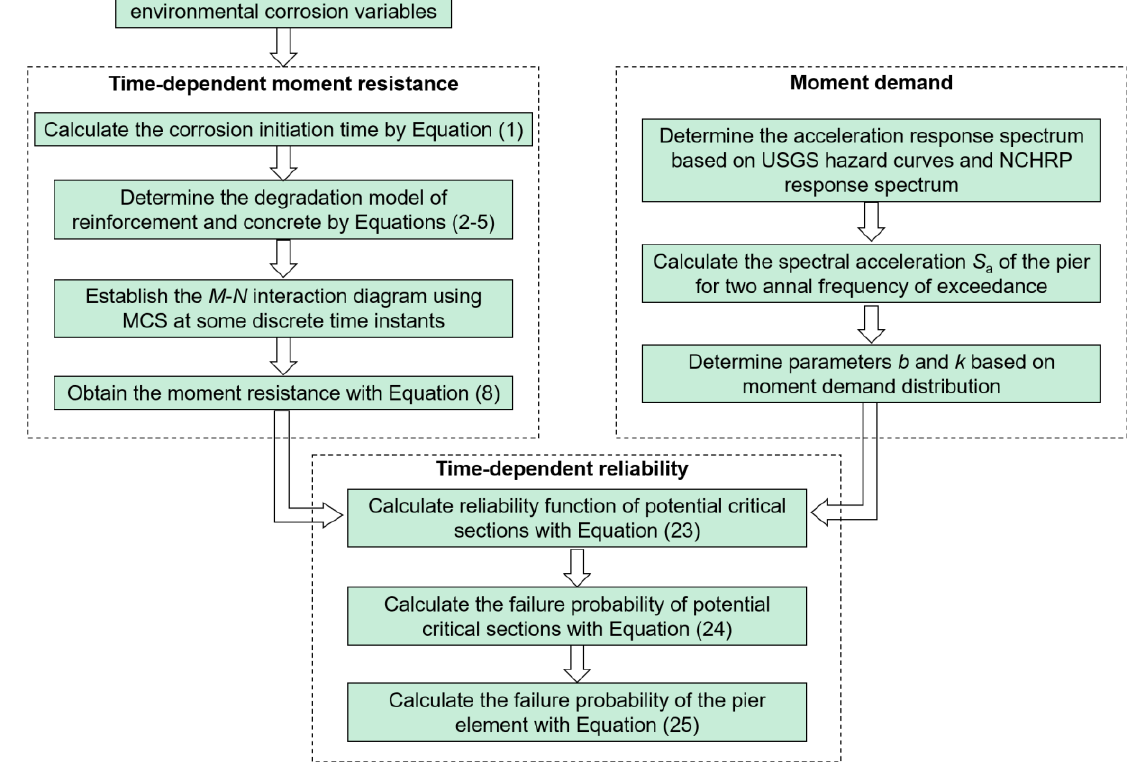
Figure 5. Flowchart of time-dependent reliability calculation.